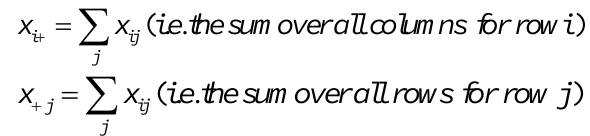
Figure 2. optimal plane separate two class with maximum